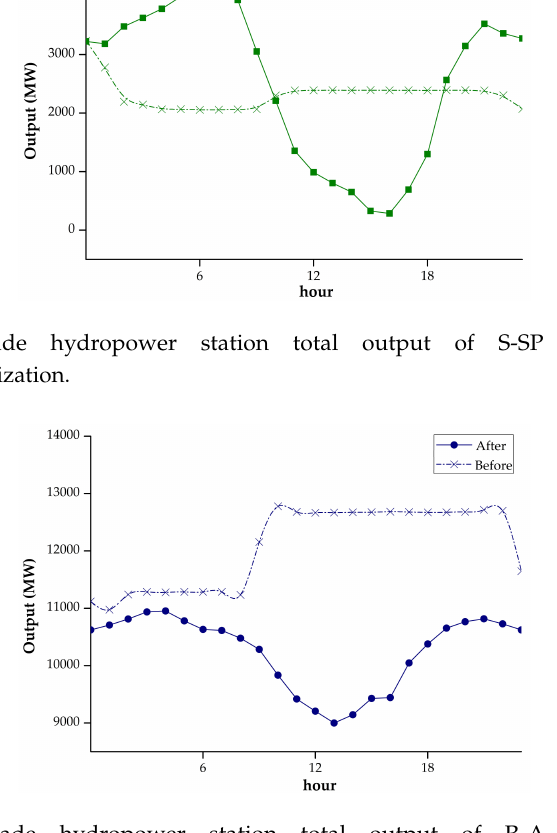
Figure 10. Cascade hydropower station total output of R-A before, and after, complementary